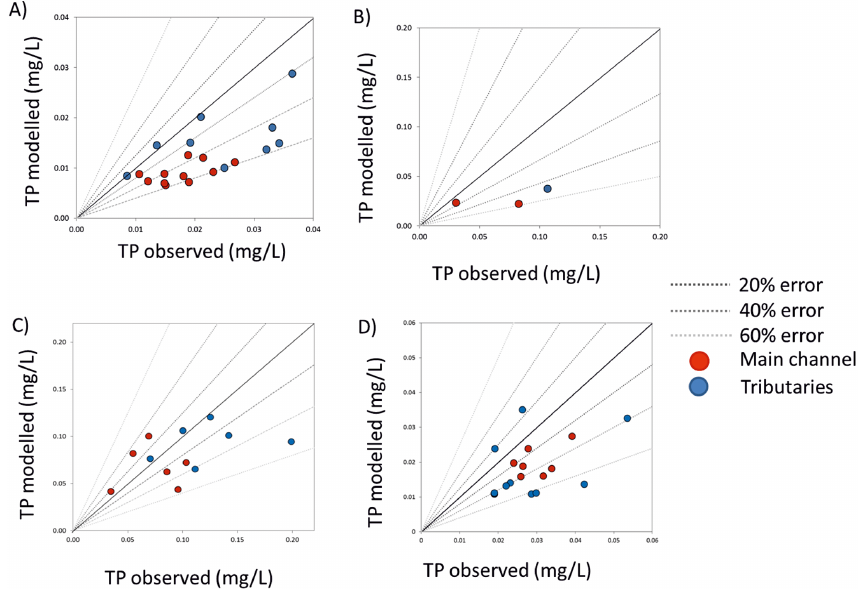
Figure 6. Spatial variability in model accuracy of total phosphorus (TP) concentrations throughout INCA models calibrated across multiple reaches, illustrating relative model error in (a) Holland, (b) Pefferlaw, (c) Beaver and (d) Whites catchments. Data represents average TP concentrations over the calibration